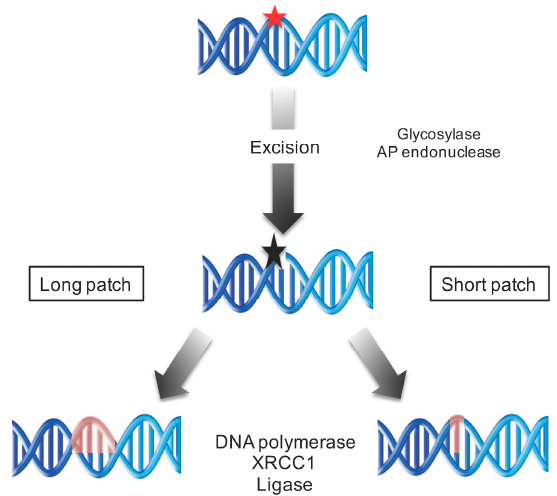
Figure 3. Schematic representation of the base excision repair (BER) pathway. The modified base is recognized and excised by specific DNA glycosyleases creating an abasic site. The gap is filled by a DNA polymerase and ligated by a DNA ligase and X-ray repair cross-complementing protein 1 (XRCC1). Red star: modified base; black star: 3’ blocking end. The newly synthetized DNA is shown in red.